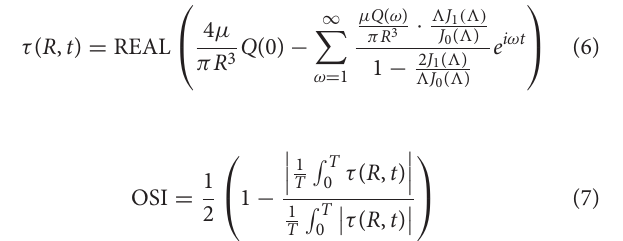
Animals PWV along aorta from carotid to femoral arteries (m/s)